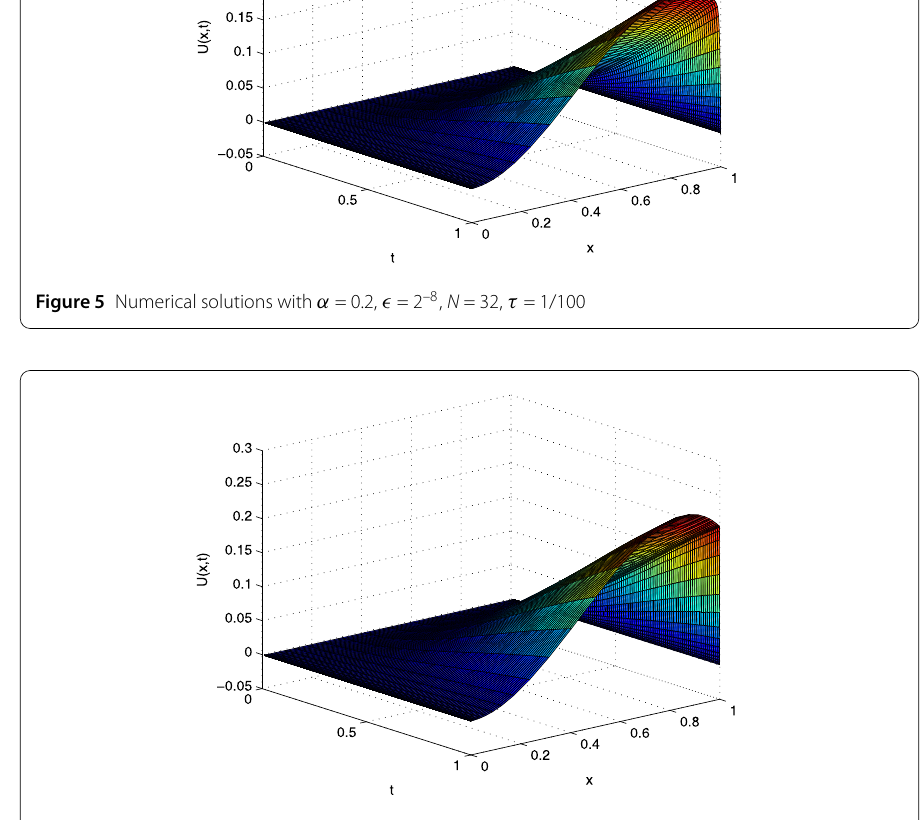
Figure 6 Numerical solutions with α = 0.2, (cid:4) = 2 –12 , N = 32, τ =